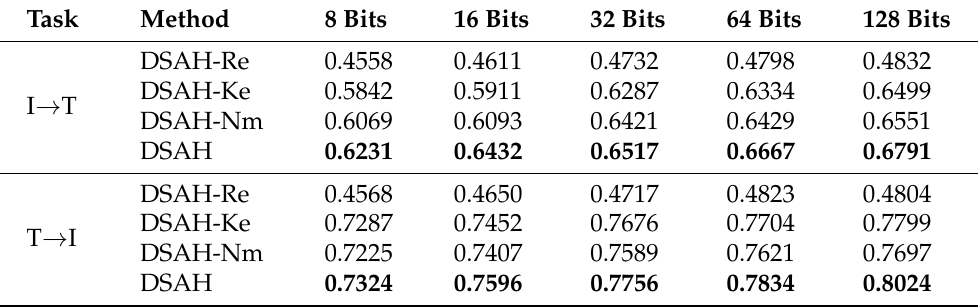
Table 5. mAP scores of different ablated versions of DSAH on NUS-WIDE dataset.